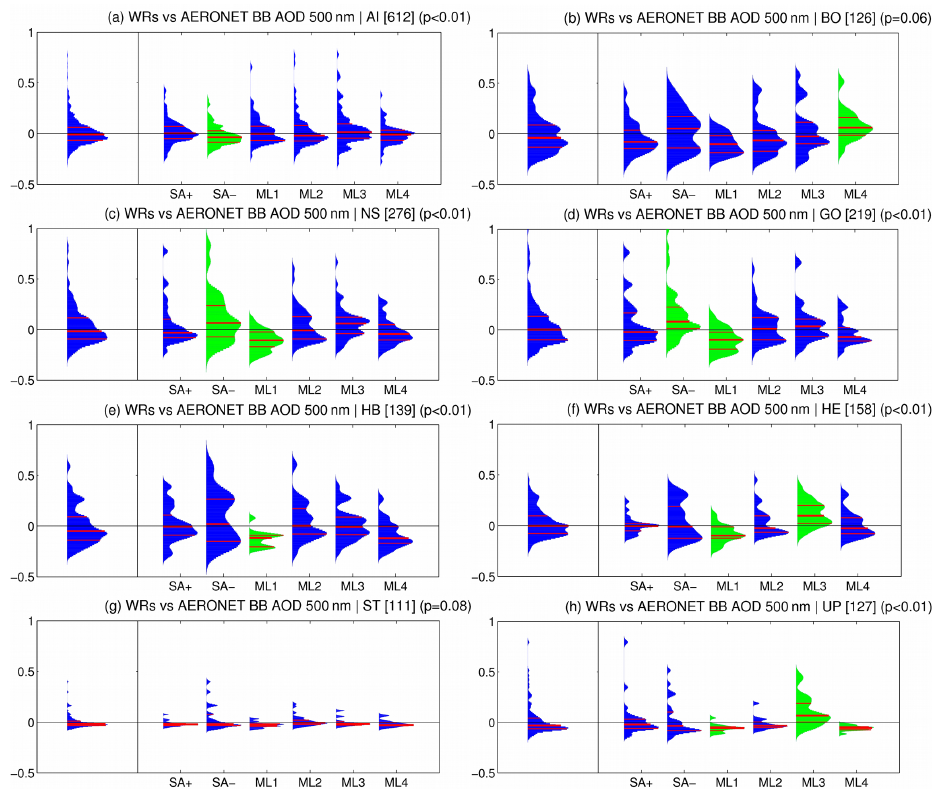
Figure 10. Circulation-to-environment characterisation for each AERONET station: (left panel) distribution of the AOD anomalies at 500nm and (right panel) for each CAMS WR. Probability density functions are estimated by using a normal kernel density; red lines represent 25th, 50th and 75th percentiles. Anomaly distributions significantly different from the climatological sample are displayed in green ( p values of the Kolmogorov–Smirnov test used to assess the significance of the differences are reported in Table S5). In titles, the number of available daily observations and the p value of the ANOVA used to assess the WR characterisation are reported in